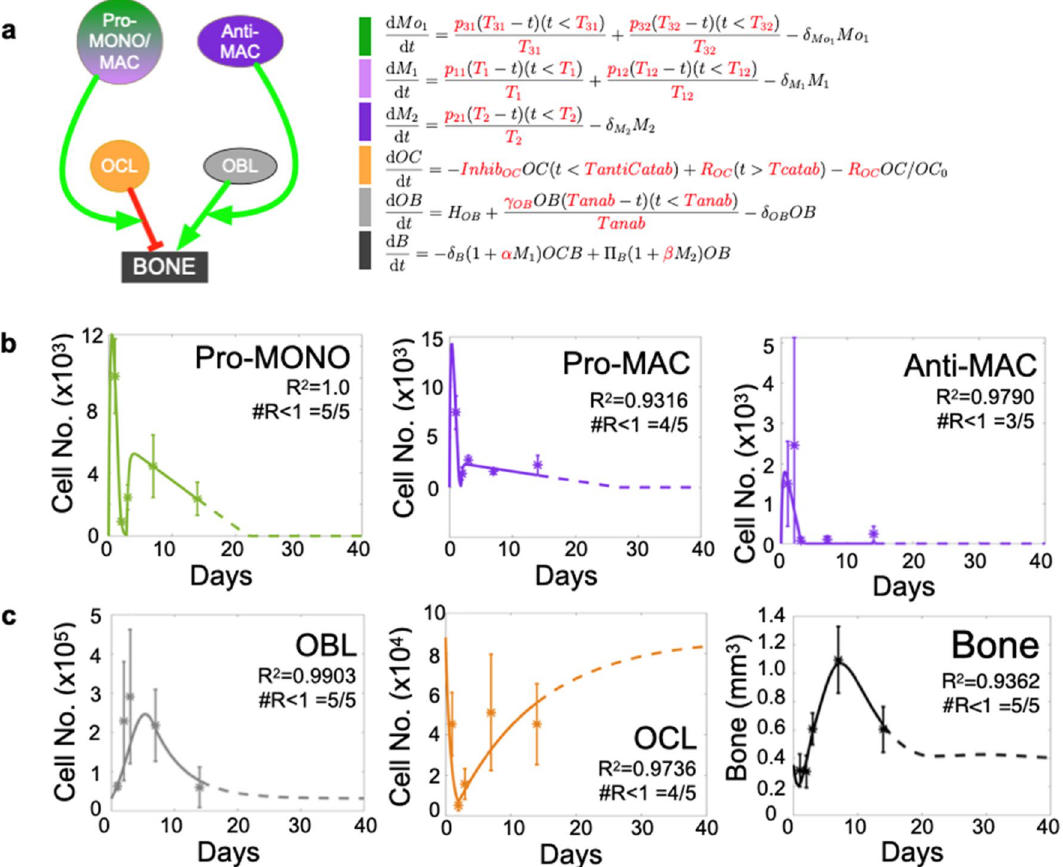
Figure 4. Integration of pro- and anti-inflammatory myeloid populations to modulate OCL and OBL activity sufficiently improves model fit to experimental bone data. ( a ) ODE expands to six populations and allows manually-fitted pro- and anti-inflammatory cells to enhance bone resorption and formation rates, respectively. Individual equations are shown next to schematic of ODE framework, model estimates amount of influence polarized myeloid cells have on bone remodeling activity to optimize fit to data (expressions in red). ( b ) Manual fits to pro- and anti-inflammatory monocytes (Pro- and Anti-MONO, respectively), anti-inflammatory macrophages (Anti-MAC) are represented by solid lines through error bar of data. ( c ) Myeloid data was used to predict bone dynamics given OBL and OCL fits. Statistical analysis of resulting fits on OCL, OBL and bone are shown (R 2